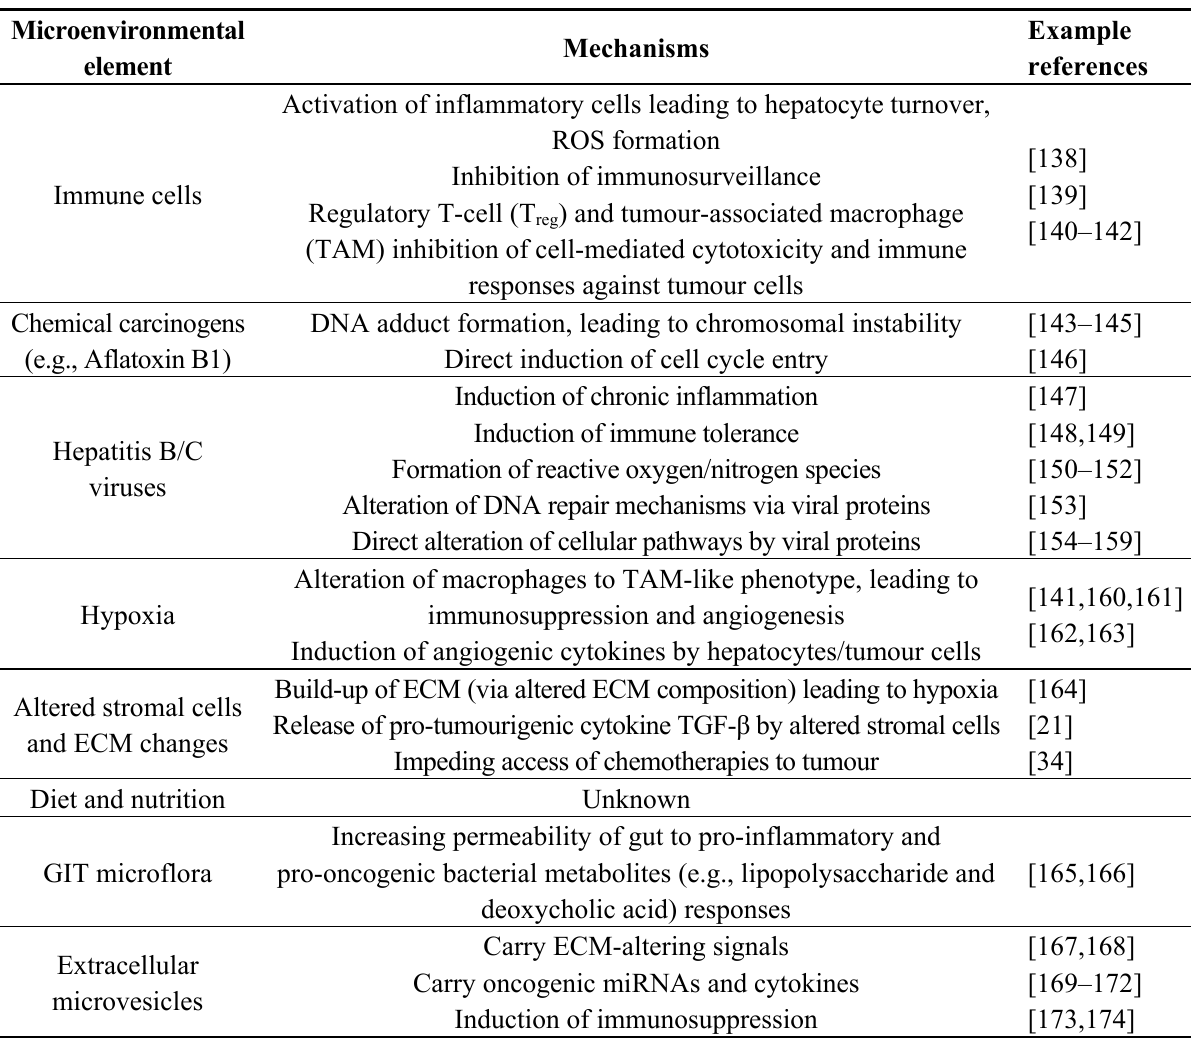
Table 2. Established and novel elements of the liver microenvironment and their roles in driving HCC progression